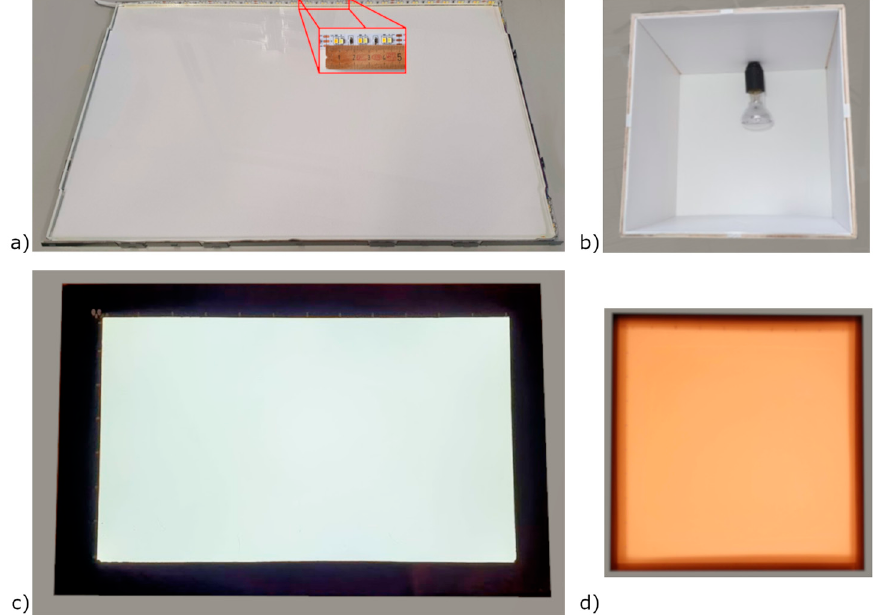
Figure 1. Luminance device based on a DIY approach: ( a ) LED panel as built; ( b ) wood cube with halogen E27 bulb lamp as built; ( c ) LED panel finished; ( d ) wood cube with warm white halogen lamp finished.